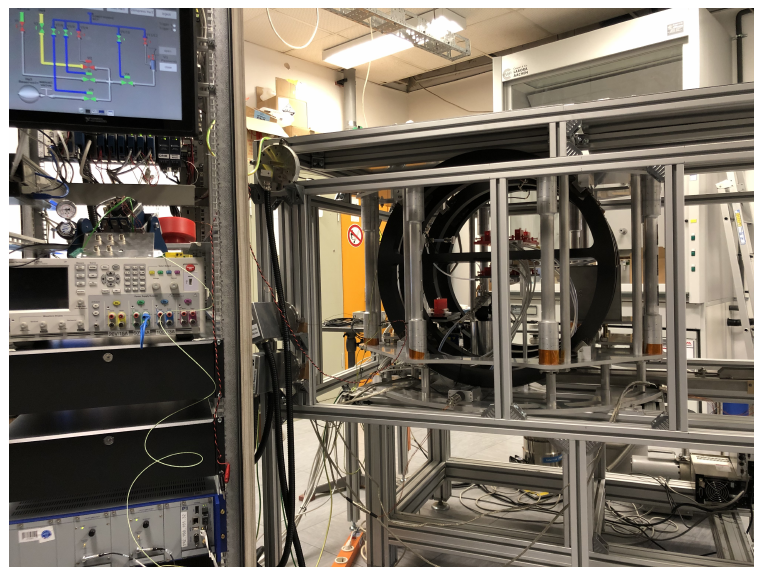
Figure 19. Rack with the control system ( left side) and the magnetic system located inside a model of the laser vacuum chamber ( right